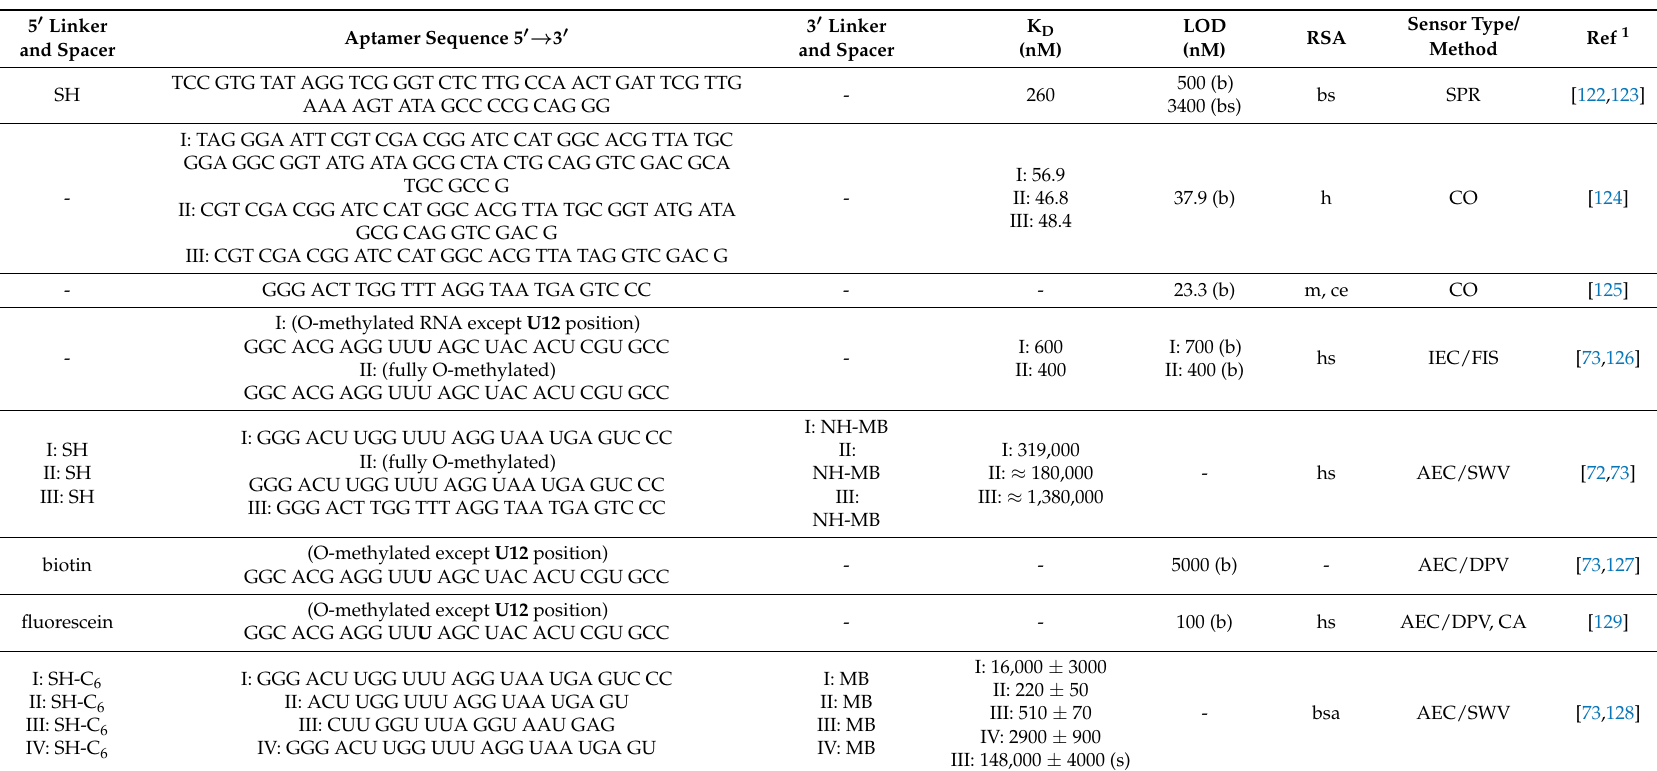
Table 6. Aptamer sequence, dissociation constant (K D ), limit of detection (LOD), real sample analysis (RSA), and realized sensor type and measuring method for tobramycin, mentioned in the corresponding references (Ref). AEC = amperometric electrochemical, b = buffer, bs = blood serum, bsa = bovine serum, albumin, CA = chronoamperometry, ce = chicken egg, CO = colorimetric, DPV = differential pulse voltammetry, FIS = Faradaic impedance spectroscopy, h = honey, hs = human serum, IEC = impedimetric electrochemical, m = milk, MB = methylene blue, SPR = surface plasmon resonance, and SWV = square wave